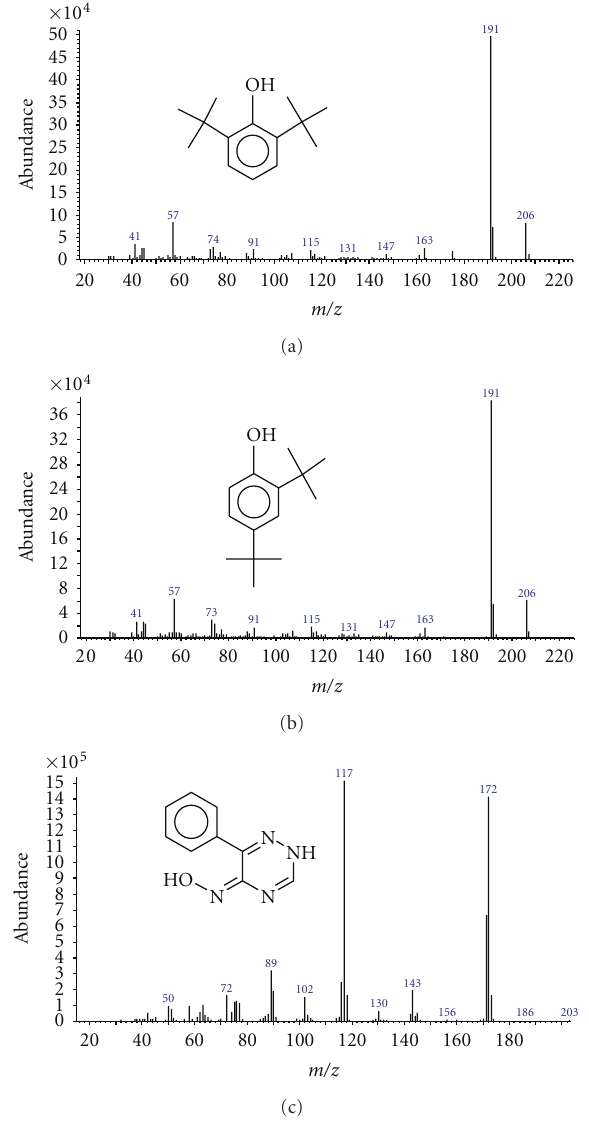
Figure 3: Mass spectra and structural formula of the identified compounds, using pure standard substances and the NIST 05 mass spectra library. The x -axis of each mass spectrum shows the m/z (mass to charge) units. (a) 2,6-di- tert -butyl-phenol, (b) 2,4-di- tert - butyl-phenol, and (c) 6-phenyl-2(H)-1,2,4-triazin-5-one oxime.